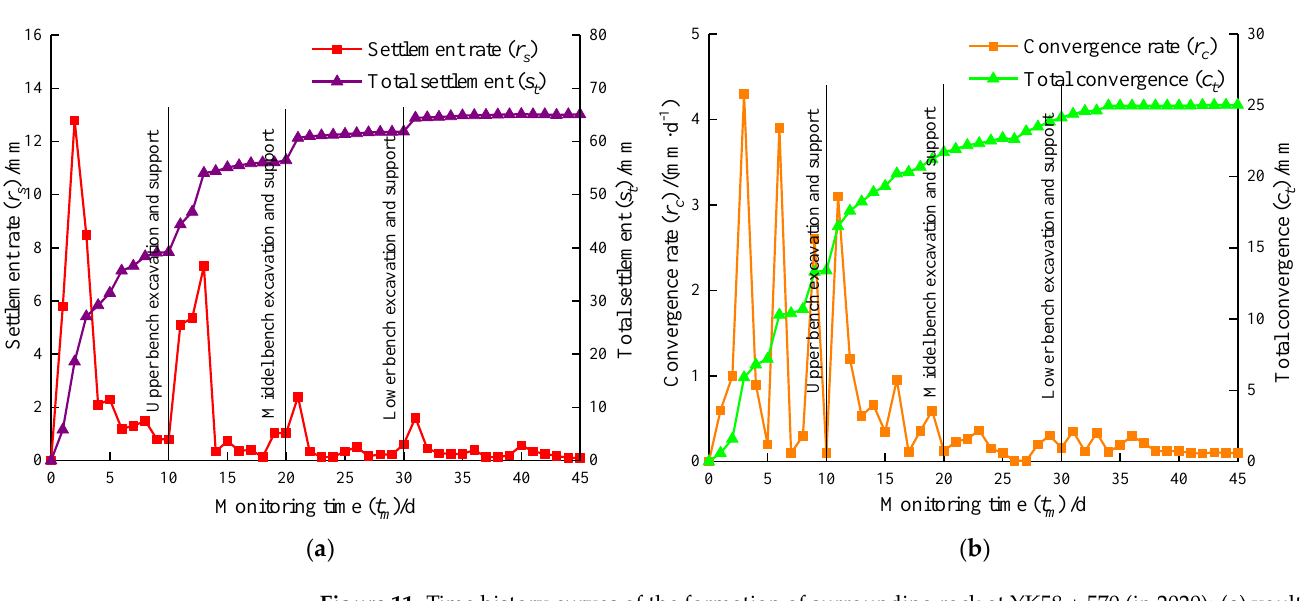
Figure 11. Time history curves of the formation of surrounding rock at YK58 + 570 (in 2020): ( a ) vault settlement; ( b ) horizontal